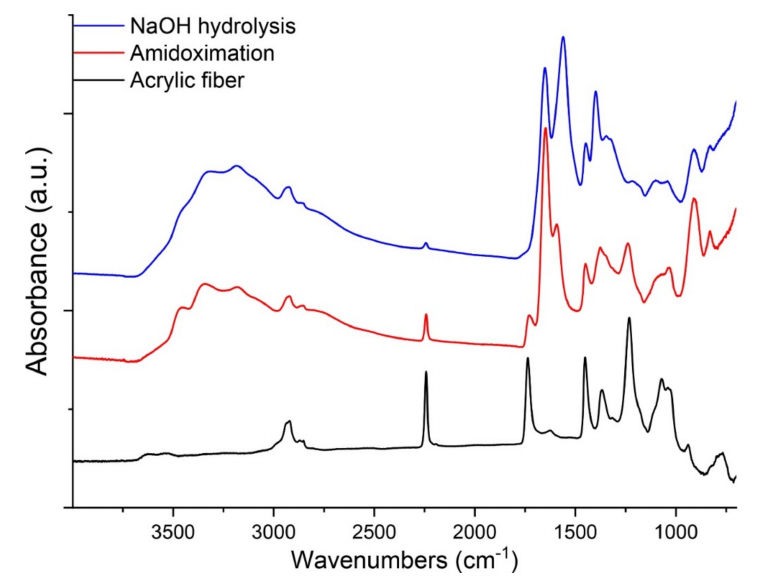
Figure 3. FTIR spectra of the original acrylic fiber (black), after amidoximation (step 1, red) and after alkaline hydrolysis (step 2, blue). Conditions: step 1, NH 2 OH, 70 ◦ C, 45 min and step 2, NaOH, room temperature, 24